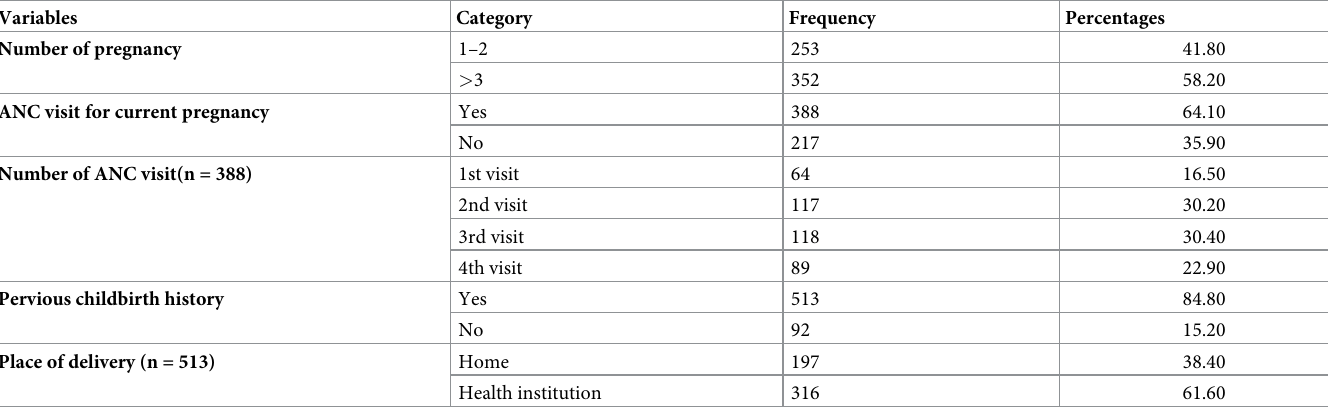
Table 2. Maternal health services utilization among pregnant women.